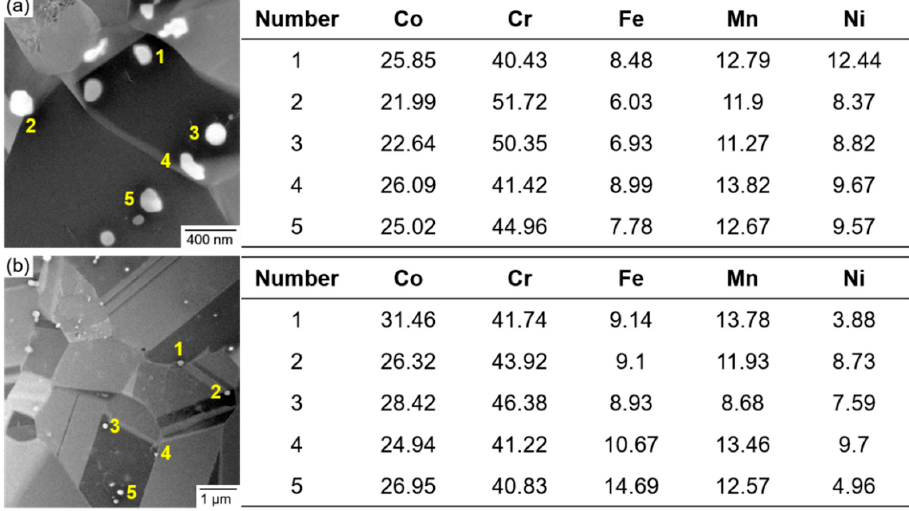
45.78 ± 4.57% (Cr), 7.64 ± 1.06% (Fe), 12.49 ± 0.86% (Mn), and 9.77 ± 1.42% (Ni) in atomic percent, respectively. The corresponding components of the HT2 sample are 27.62 ± 2.22% (Co), 42.82 ± 2.08% (Cr), 10.51 ± 2.19% (Fe), 12.08 ± 1.82% (Mn), and 6.97 ± 2.21% (Ni) in